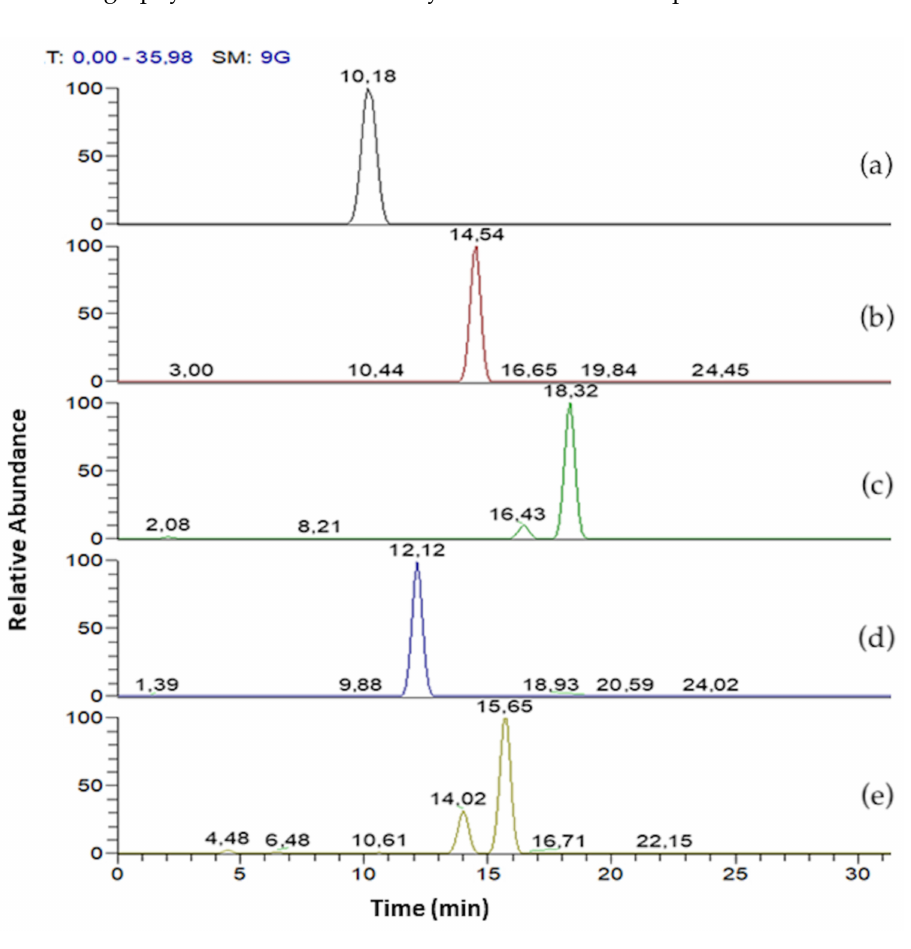
Figure 3. LC-MS/MS mass chromatogram of R89BS crude extract. Mono-rhamnolipids with [M–H] − at m/z 475 ( a ), 503 ( b ), 531 ( c ). Di-rhamnolipids with [M–H] − at m/z 649 ( d ) and 677 ( e